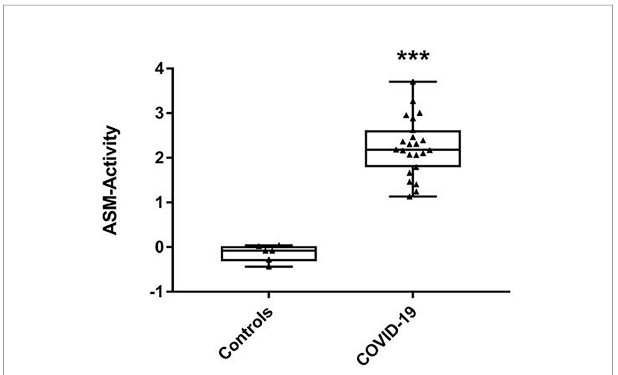
FIGURE 4 | Activity levels of acid sphingomyelinase (ASM) in serum samples. Shown are medians with interquartile ranges of ASM activity levels from 23 severe COVID-19 patients and six volunteers as healthy controls, measured in separate aliquots used for ceramide pro fi ling. Statistical signi fi cance was tested using the Mann-Whitney U-test; statistical difference is indicated by asterisks: ***p <